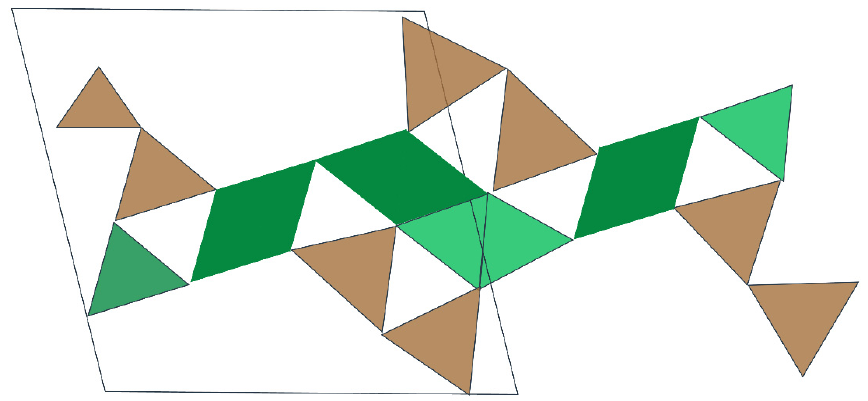
Figure 6. Molecular structure models of jennite [86].